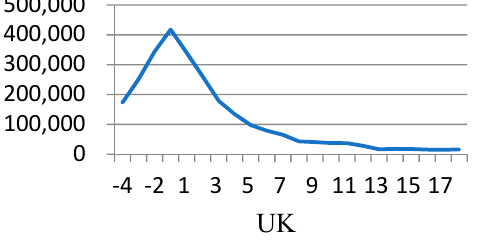
Figure 2. The trend of weekly new confirmed cases in the UK and the USA.